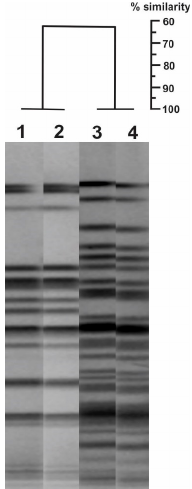
Figure 1. Genetic relationship by Pulsed-Field Gel Electrophoresis (PFGE) of the Pseudomonas aeruginosa